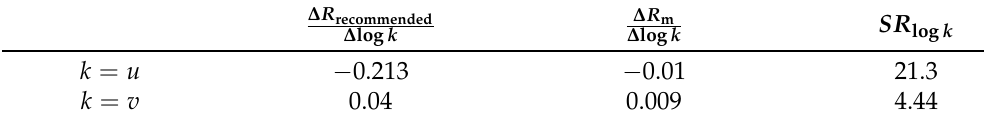
Figure 18. Changes in the detection rate of recommended area and the misclassification rate of non-traversable area by loss weighting: ( a ) changes in the detection rate of recommended area by varying loss weight for unclassified area; ( b ) changes in the detection rate of recommended area by varying loss weight for non-traversable area; ( c ) changes in the misclassification rate of non-traversable area by varying loss weight for unclassified area; and ( d ) changes in the misclassification rate of non-traversable area by varying loss weight for non-traversable area. Table 4. Derivation of sensitivity ratio ( SR